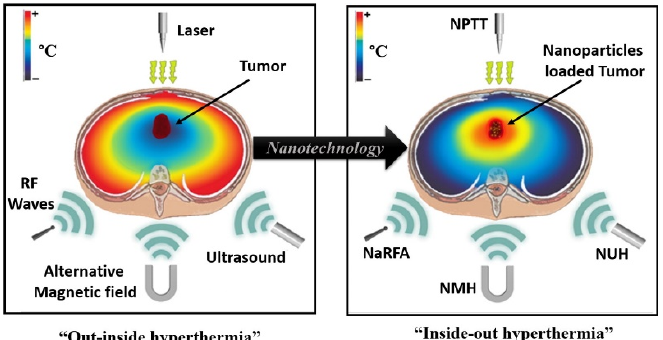
Figure 1. Thermal hypothermia of a tumor using nanoparticles enclosed inside of it, absorbing the energy coming from different heat sources. NPTT: Nano-Photothermal Therapy; NMH: Nano-Magnetic Hyperthermia; NaRFA: Nano-Radio-Frequency Ablation; NUH: Nano-Ultrasound Hyperthermia. Reproduced from [13], with permission from Elsevier, Copyright 2016.